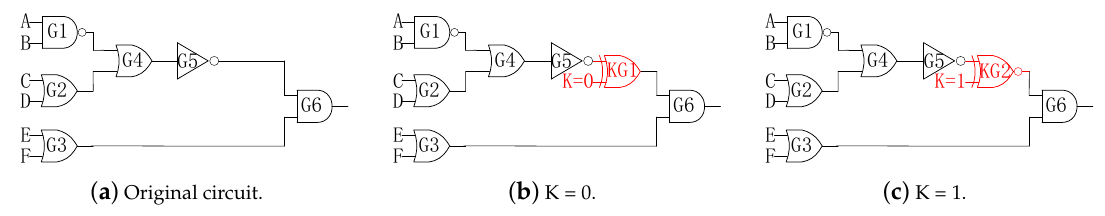
Figure 1. Logic encryption through inserting the